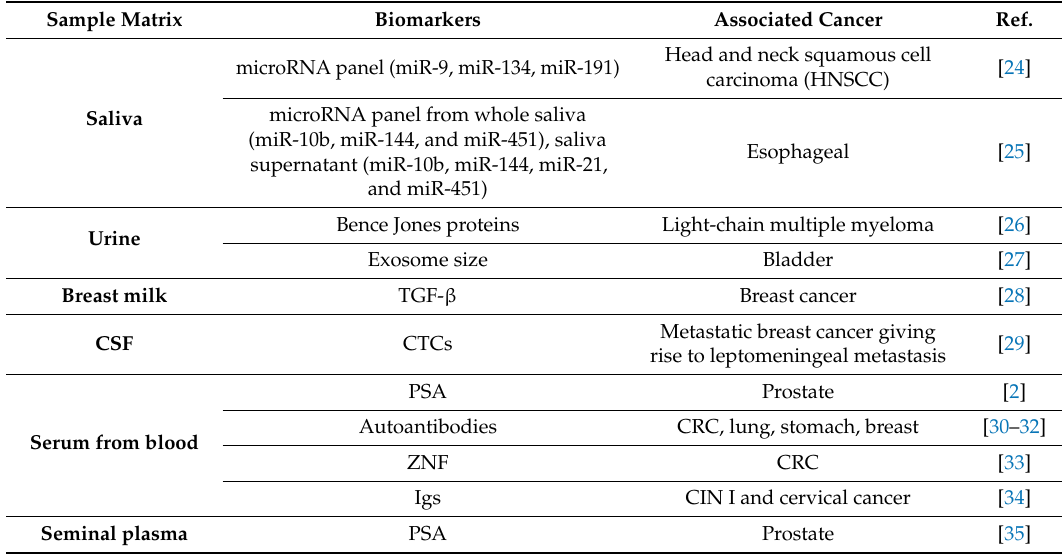
Table 1. Overview of some important sample matrices and associated